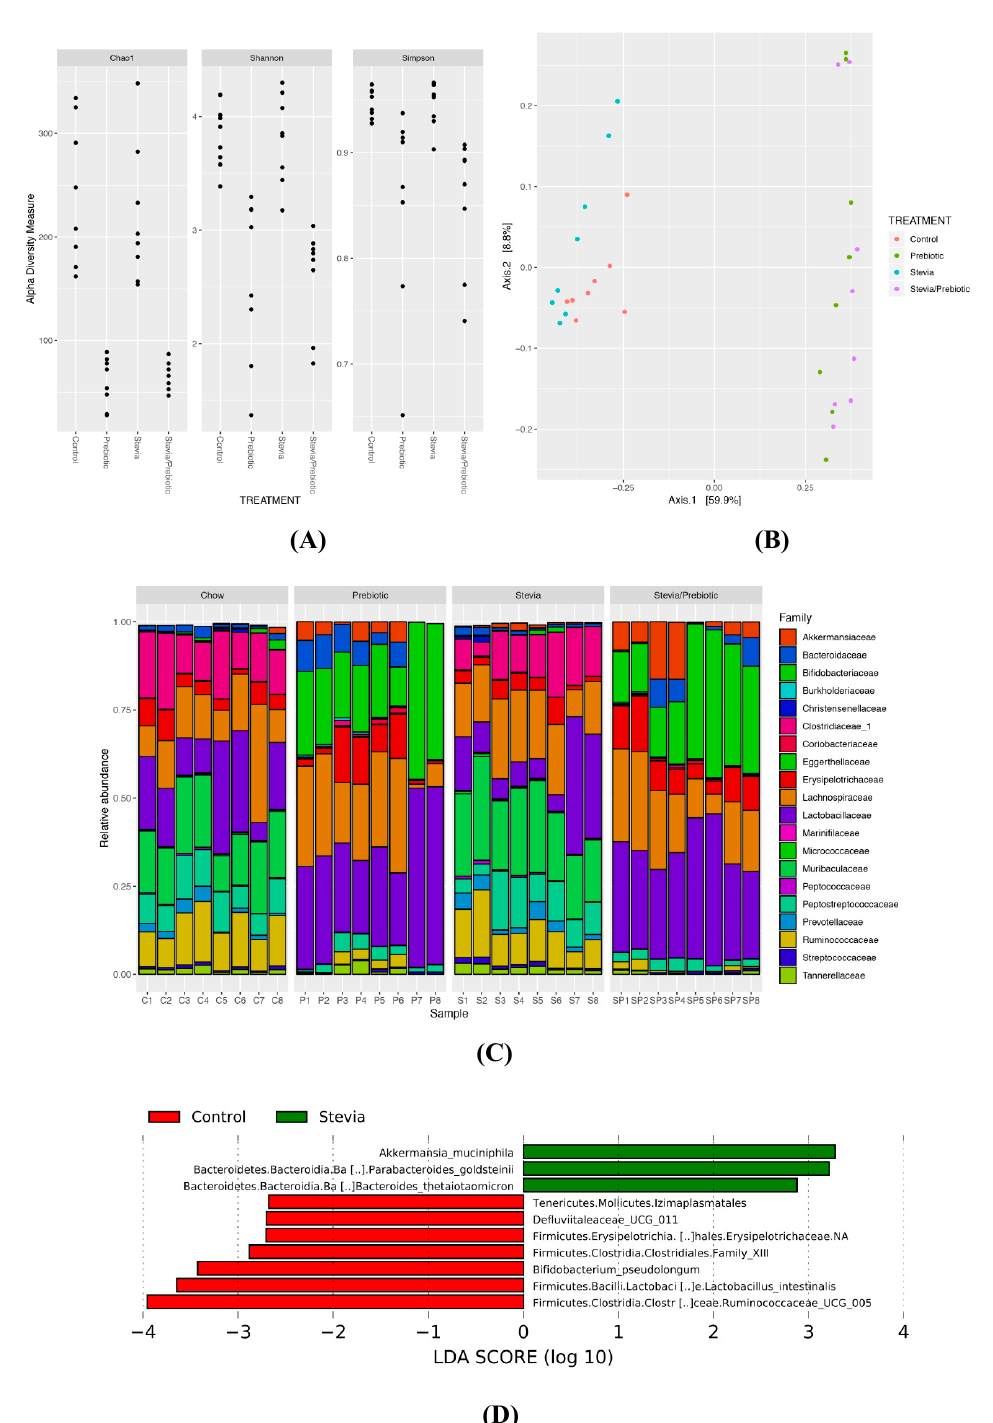
Figure 4. Alpha and beta-diversity and the relative abundance of the most discriminant bacterial groups according to LEfSe in male rats consuming RebA, prebiotics, both or neither for 9 weeks. (a) Alpha-diversity measures; (b) beta-diversity measures; (c) bar plot of microbiota abundance at the family level; (d) linear discriminant analysis (LEfSe) describing the greatest differences between stevia (RebA) and control microbial communities; n = 8/group.